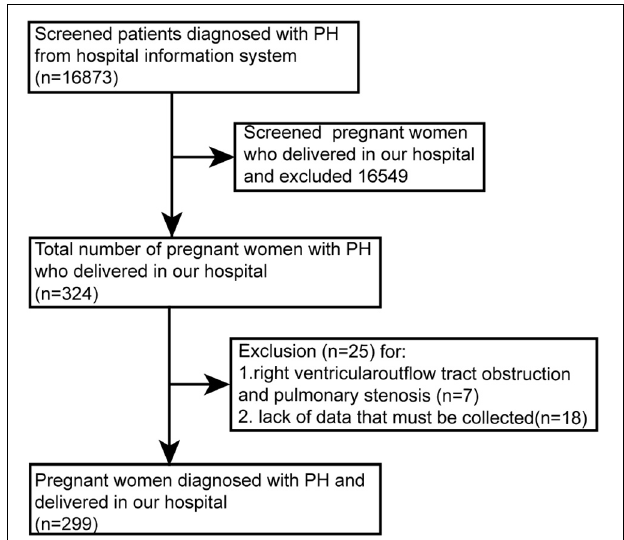
FIGURE 1 | Patient flow chart. PH, pulmonary